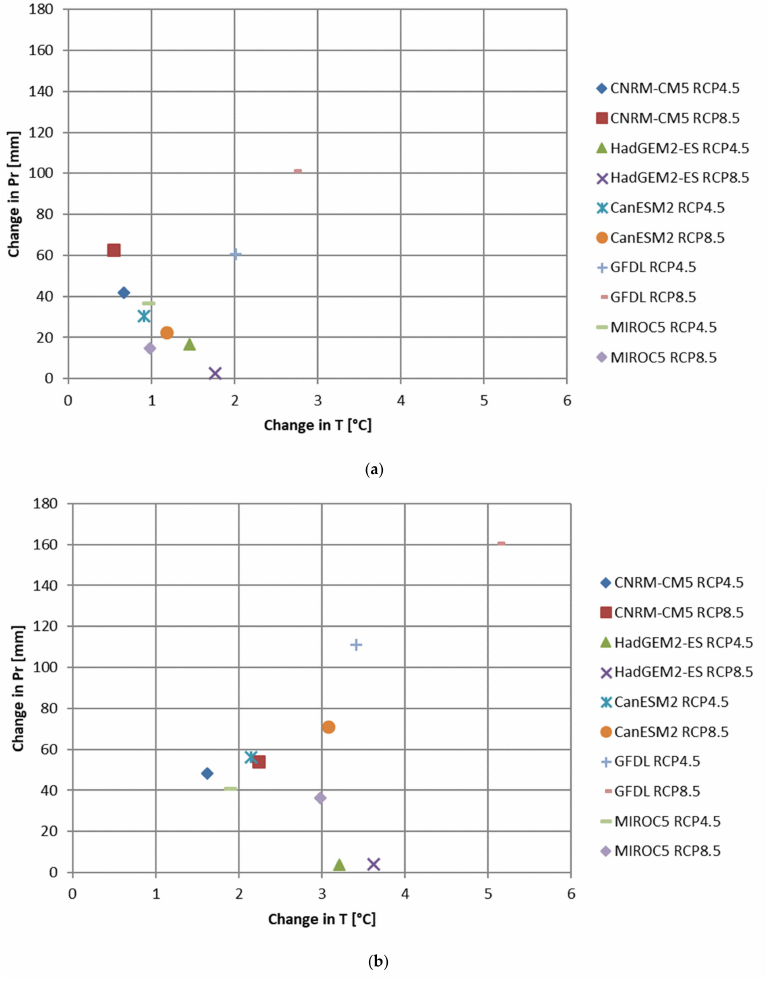
Figure 2. Change in annual temperature and precipitation according to different scenarios at the Lahti Laune meteorological station: ( a ) near future 2010–2039, ( b ) far future